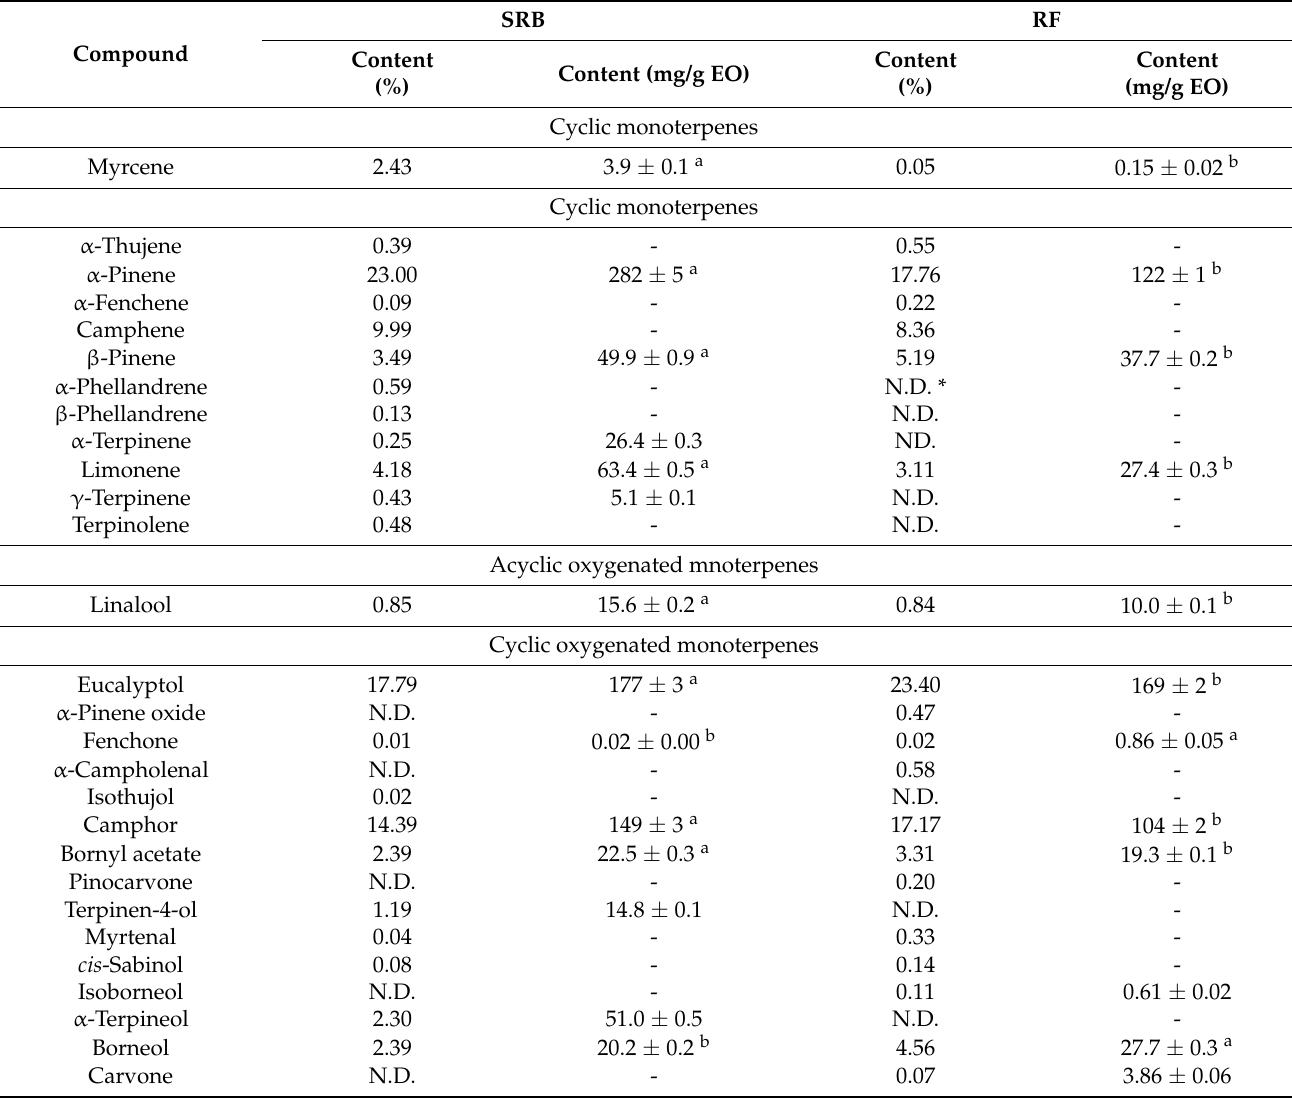
Table 1. Chemical profile, relative content (%), and quantitative profile of Serbian (SRB) and Russian (RF) rosemary essential